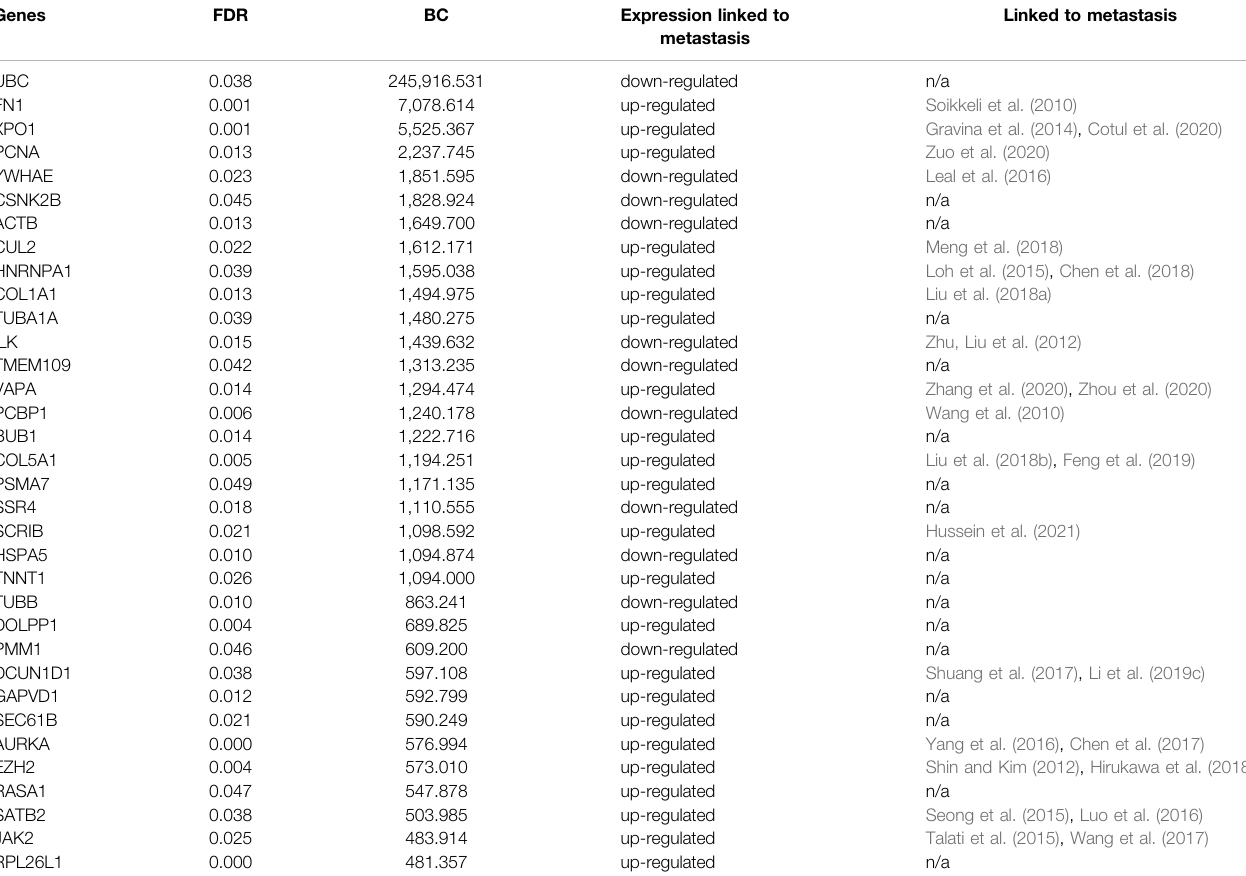
TABLE 5 | Metrics and literature linking the 34 feature genes to metastasis or speci fi cally BM.